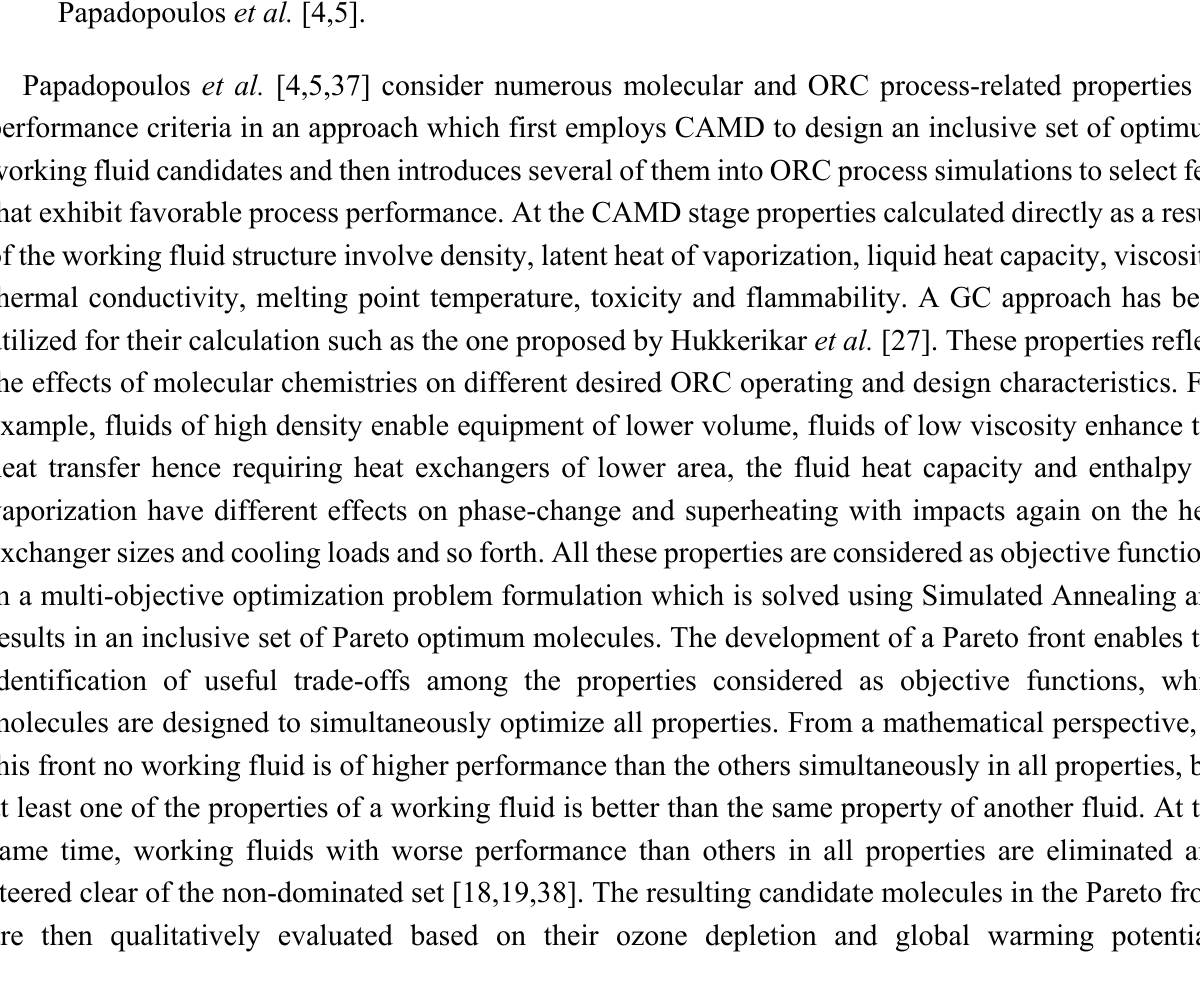
Figure 3. Algorithmic steps involved in the optimization-based CAMD approach used in Papadopoulos et al.